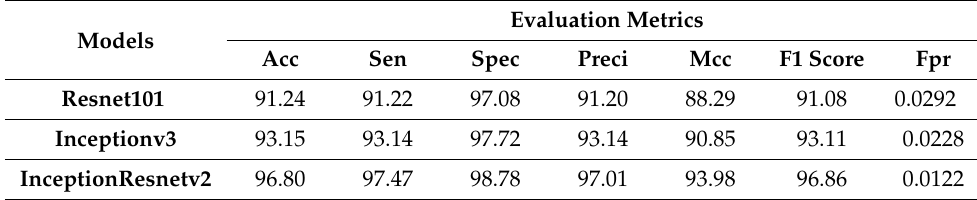
Table 6. Results for pre-trained-MCSVM based models with image SR using dataset #1.